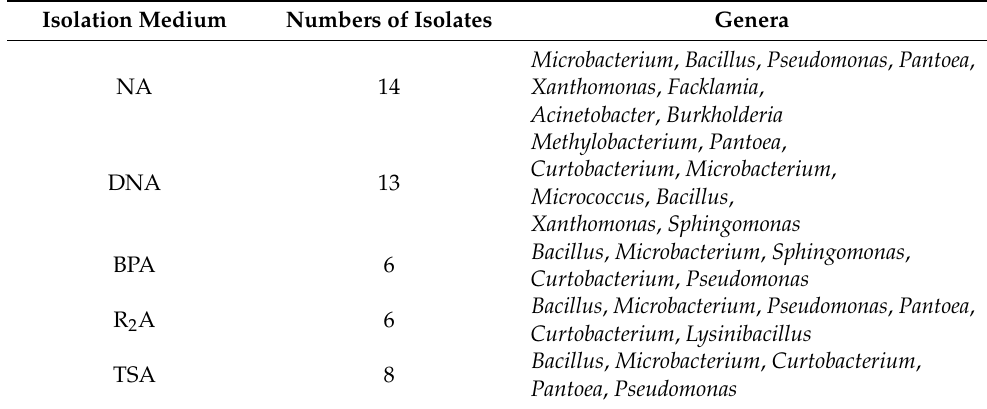
Table 1. The numbers and genera of endophytic bacteria recovered on the five different isolation media from DXWR seeds.